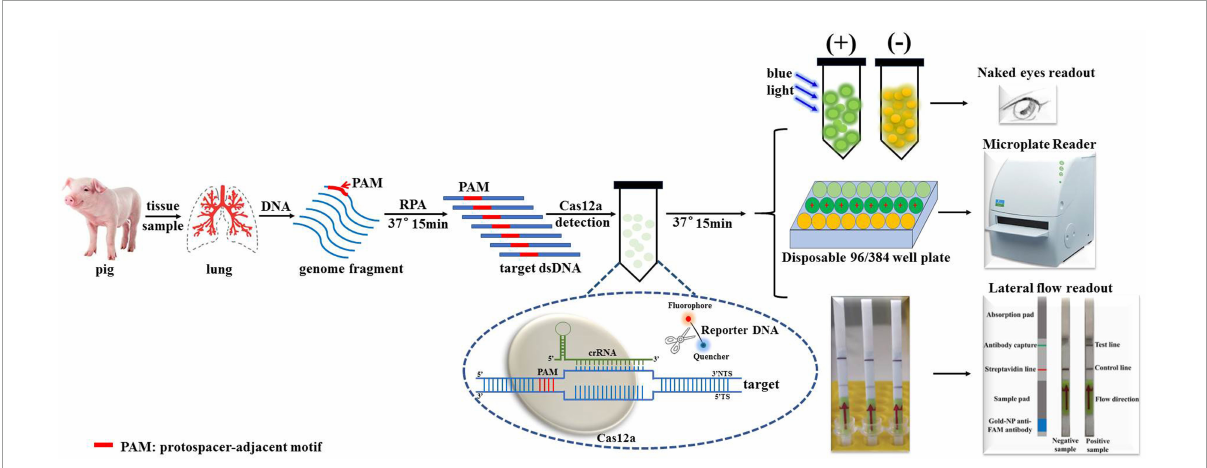
FIGURE1 Schematic diagram of Cas12a/crRNA-assisted rapid detection (Card) platform for identification of A. pleuropneumoniae . Gene targets are specifically pre-amplified from genome fragments isolated from clinical samples by RPA. The specific crRNA probes were designed to target amplified fragments, and mixed with Cas12a/crRNA/ssDNA-FQ. Once the target DNA is recognized by the complex formed by Cas12a and crRNA, Cas12a exhibits non-specific endonuclease activity and cleaves the fluorescently labeled reporter (fluorophore [F] is quenched by a quencher [Q]) resulting in fluorescence, which is detected in a microplate reader, or observed by the naked eye under blue